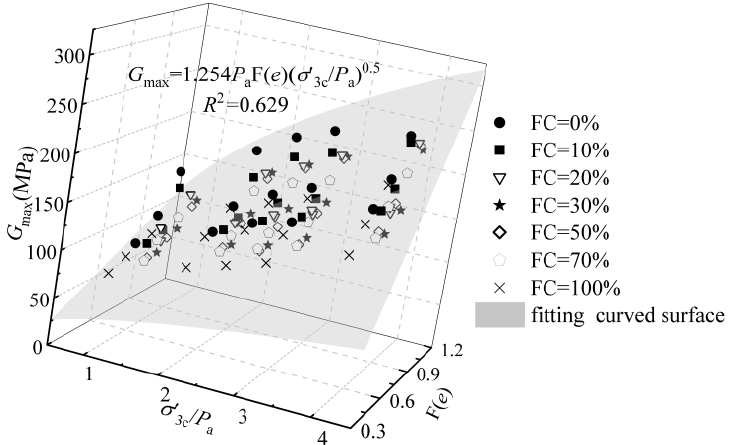
σ′ / P a of the sand-silt mixed soil